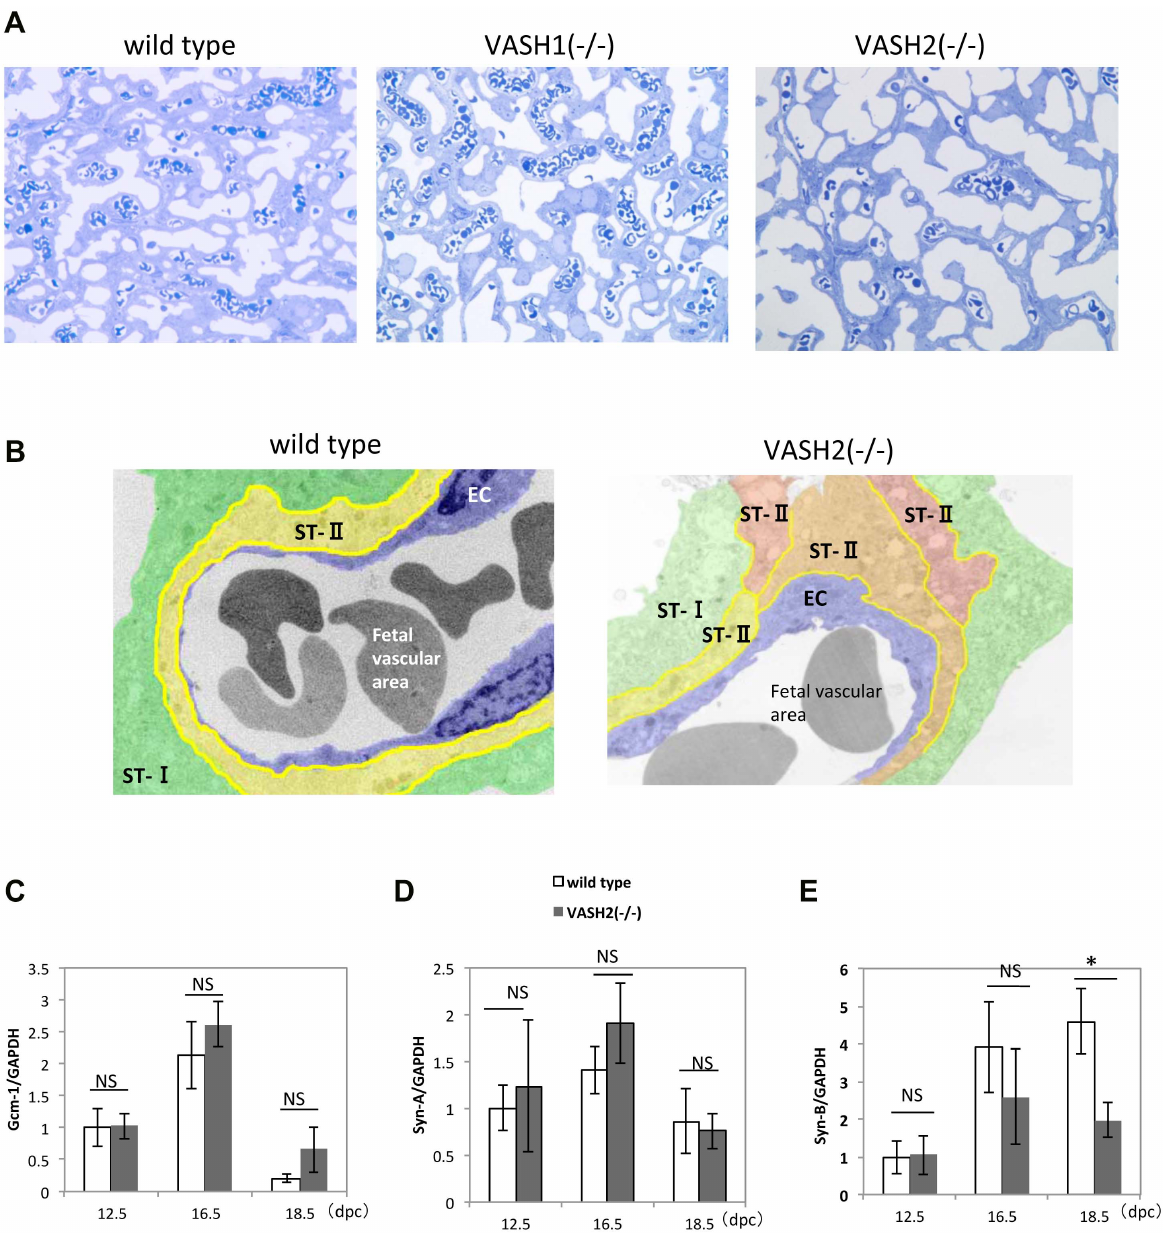
Figure 5. Labyrinth and syncytiotrophoblast layers of WT, Vash1 ( 2 / 2 ) and Vash2 ( 2 / 2 ) mice. A: Semi-thin sections of the labyrinth layer of WT, Vash1 ( 2 / 2 ) , and Vash2 ( 2 / 2 ) placentas. Bar=20 m m. B: Electron microscopic pictures of WT and Vash2 ( 2 / 2 ) placentas. Purple indicates ECs; green, ST-I; and yellow, ST-II. Bar=5 m m. C–E: Expression of Gcm-1, Syn-B, and Syn-A in WT, Vash1 ( 2 / 2 ) and Vash2 ( 2 / 2 ) placentas at the indicated dpc, was determined by qRT-PCR. At 12.5, 16.5, and 18.5 dpc, the respective placenta numbers were 7, 6, and 5 for WT; 7, 7, and 7 for Vash1 ( 2 / 2 ) ; and 5, 7, and 6 for Vash2 ( 2 / 2 ) . *P , 0.01, NS; not significant.